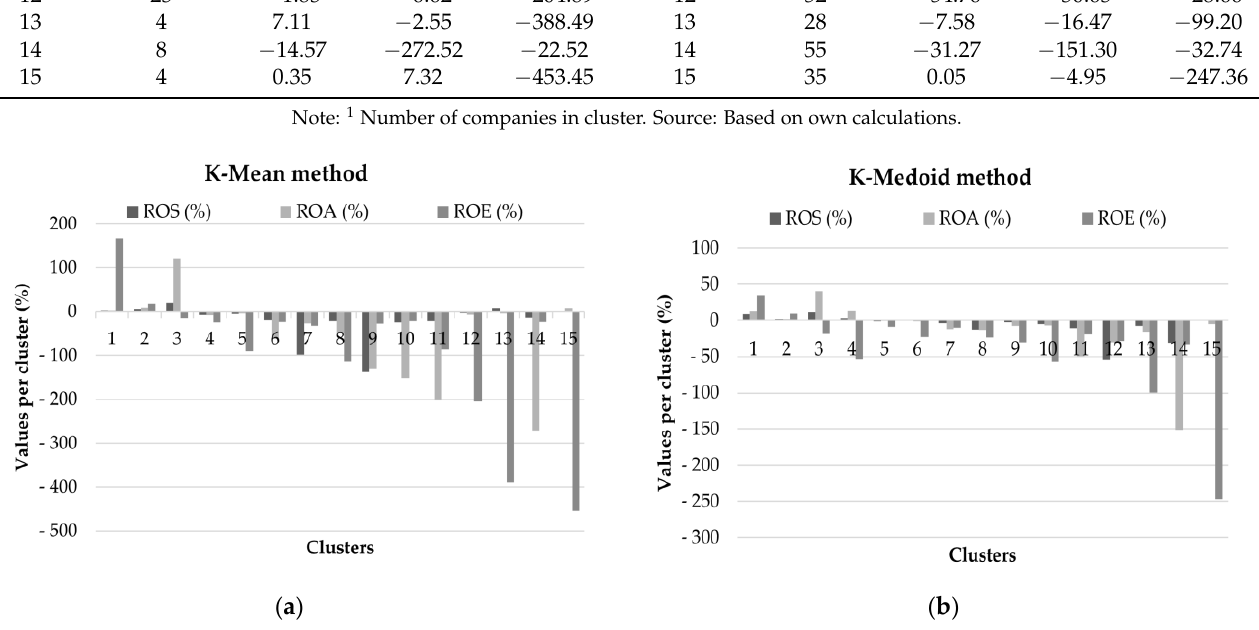
Table 7. Average financial indicator values per cluster (%) for Romanian companies. K-Mean